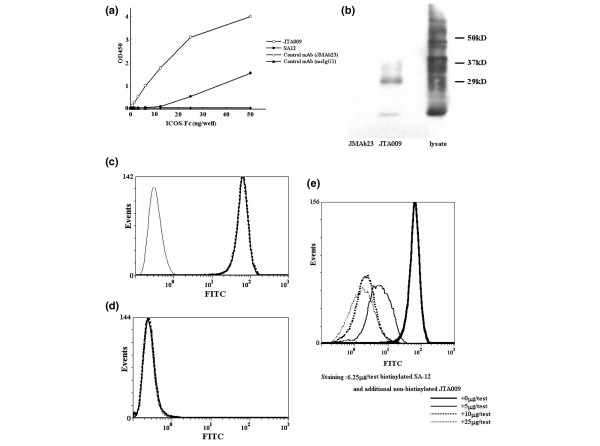
Characterization of JTA009, a novel anti-human ICOS mAb. JTA009, a fully human anti-human ICOS mAb, has greater avidity than SA12. (a) Avidity of anti-human ICOS antibodies was evaluated by direct ELISA using ICOS-Fc (as described in Materials and method). JTA009 (open circles) exhibited stronger binding to ICOS-Fc than did SA12 (closed circle), a previously reported anti-human ICOS mAb. (b) Peripheral blood T cells from normal control individuals were stimulated with anti-CD3 mAb (0.1 μg/ml) plus anti-CD28 mAb (2 μg/ml) for 72 hours. These cells were biotinylated and cell lysates were prepared. ICOS molecules in these lysates were immunoprecipitated, separated on SDS-PAGE gel, transferred to nitrocellulose membrane, and visualized using streptavidin-peroxidase and chemiluminescent substrate. A single band about 29 kDa was immunoprecipitated with JTA009 but not with JMAb23, the control antibody. The thin lower band corresponded to the position of the front dye of the gel. Human ICOS expressing (c) CHO-K1 and (d) its parental cell line CHO-K1 were stained with biotinylated JTA009 (thick line), biotinylated SA12 (broken line), or biotinylated JMAb23 (human IgG2; thin line) and streptavidin-FITC, and then analyzed using flow cytometry. (e) Human ICOS expressing CHO-K1 cells were stained biotinylated SA12 (6.25 μg/test) and streptavidin-FITC in the presence of various amounts of nonbiotinylated JTA009 (thick line: 0 μg/test; thin line: 5 μg/test; thick broken line: 10 μg/test; thin broken line: 25 μg/test). JTA009 dose dependently decreased the binding of SA12 to the ICOS expressing CHO-K1 cells. FITC, fluorescein isothiocyanate; ICOS, inducible co-stimulator; mAb, monoclonal antibody.